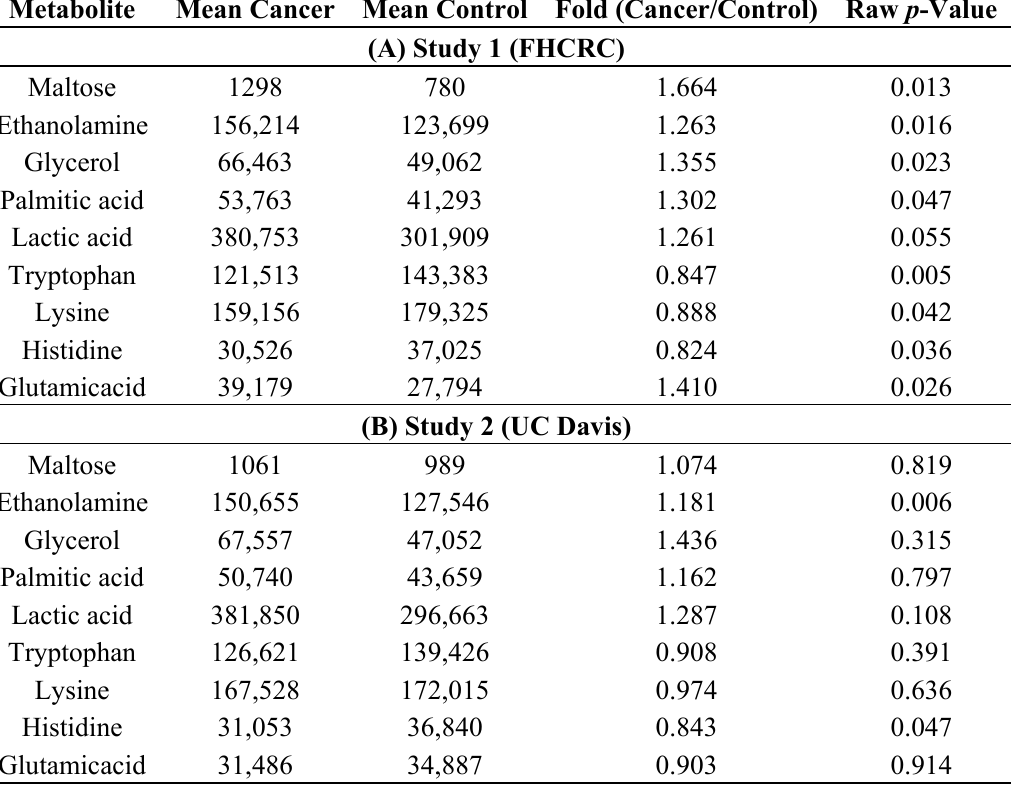
Table 2. ( A ) Means and fold change for nine known metabolites from Study 1 that differ significantly (raw p -value < 0.05) between cancer patients and disease free controls; ( B ) means and fold change for nine known metabolites from Study